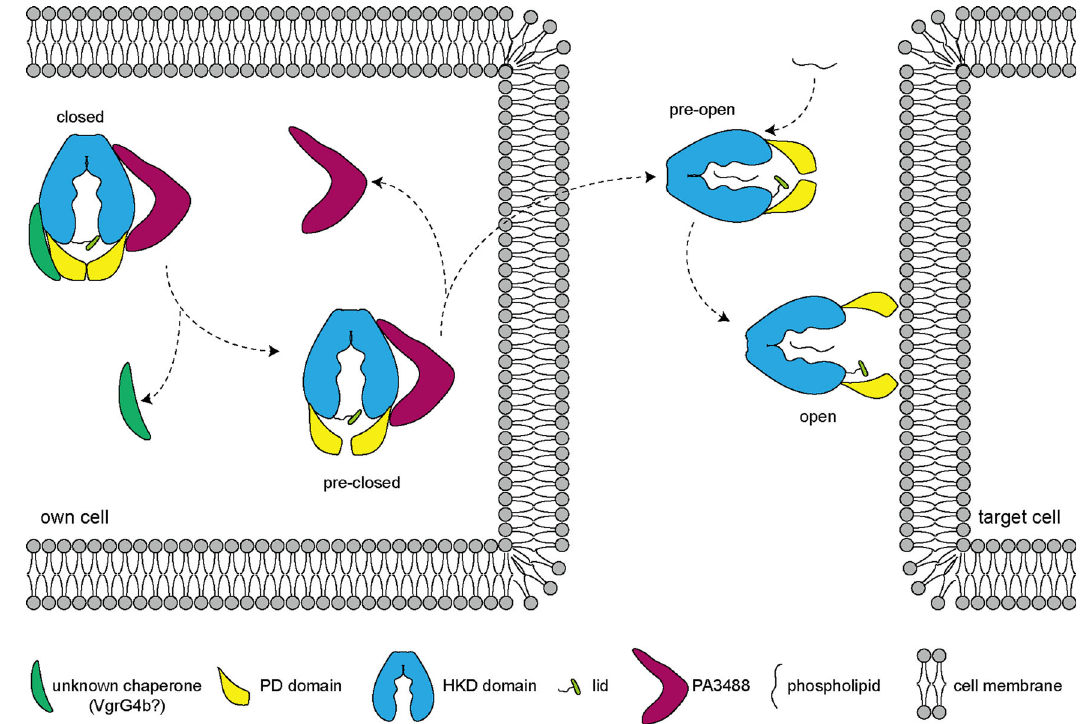
Fig. 6 | Mechanism of PldA-mediated invasion. Proposed model for the invasion of PldA into target cell. PA3488 and an unknown chaperone (probably VgrG4b) interactwithPldAtotightlyclosetheactivesite(closedstate)insidetheirowncells; once receiving a physiological signal to secrete PldA to adjacent cells, PA3488 and